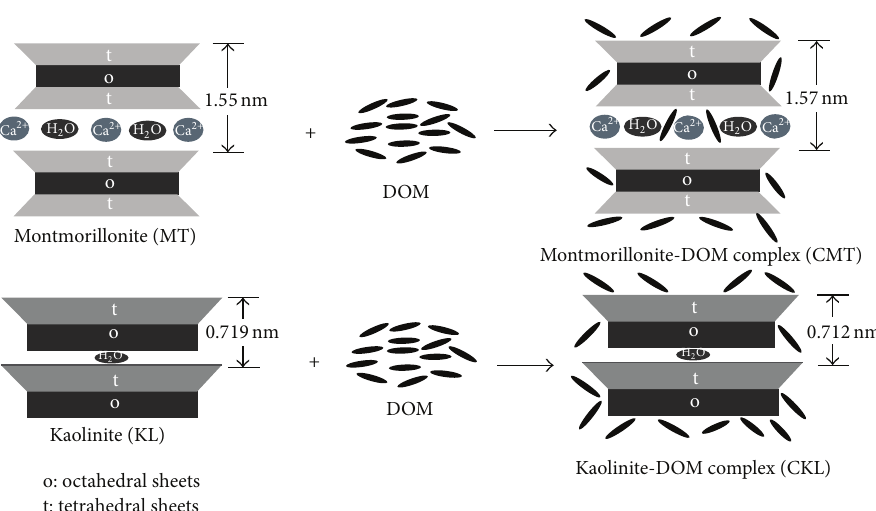
Figure 5: Schematic representation of the interfacial interactions between clays and